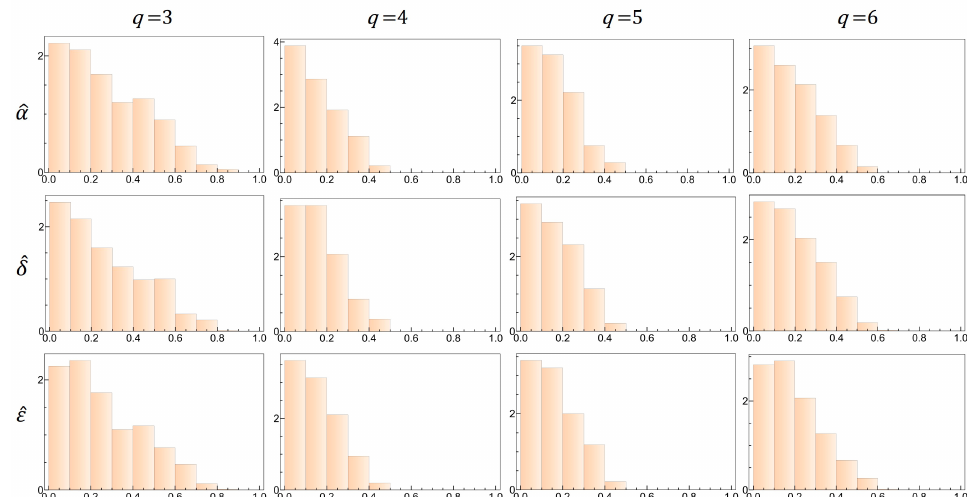
Figure 13: Histograms of the final accepted distances between observed and simulated summary statistics achieved with ABC, for model (13). Only the first three summary statistics, i.e., the parameter regressors, are plotted (rows). The columns correspond to different architectures of ENCA, that is, latent space dimensions of 3, 4, 5, or 6, as specified by the column labels.